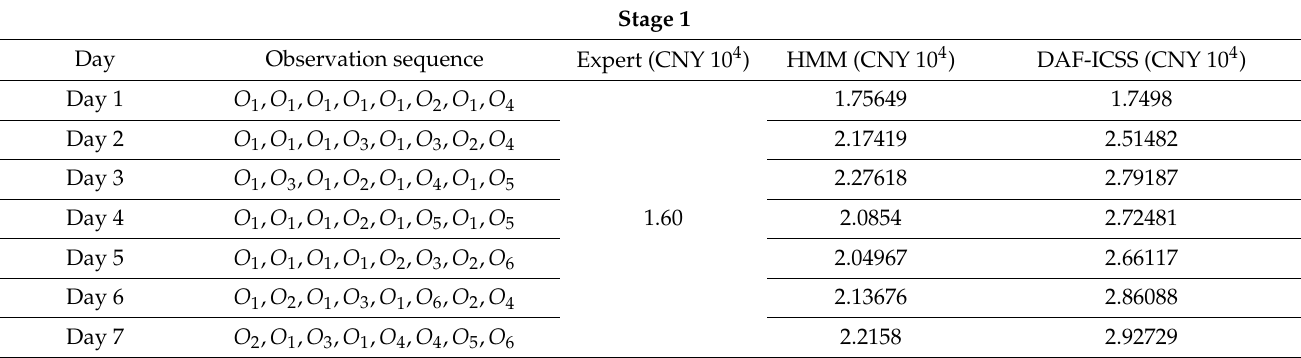
Table 10. The data of the observation